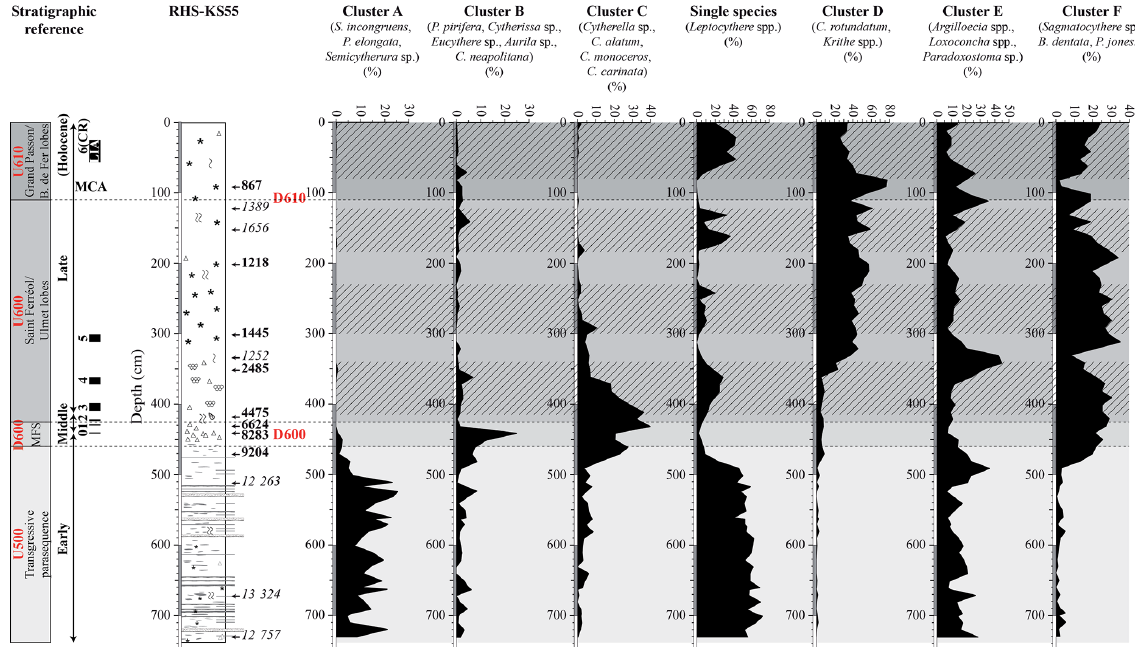
Figure 8. Cumulative percentages of taxa composing the defined ostracod clusters along core RHSKS55. Correlations with seismic units and discontinuities are shown on the left side of the figure. The corresponding positions of seismic units and discontinuities (U500, U600, U610, D600, and D610) are also reported on the plots (gray bands and dashed lines). Holocene cold relapses (CRs) are also indicated on the y axis by the black rectangles (left side of the figure). Periods of increased fluvial discharge are highlighted by peaks in Leptocythere (hatched rectangles). These periods of intensified runoffs correlate to the 2.8ka event (i.e., CR4) and the LIA (i.e., CR6). Two periods of regional climate deterioration are also observed at 1.3 and 1.1kacal.BP. Conversely, the Migration Period Cooling (i.e., CR5) and the Medieval Climate Anomaly (MCA) correspond to periods of increased